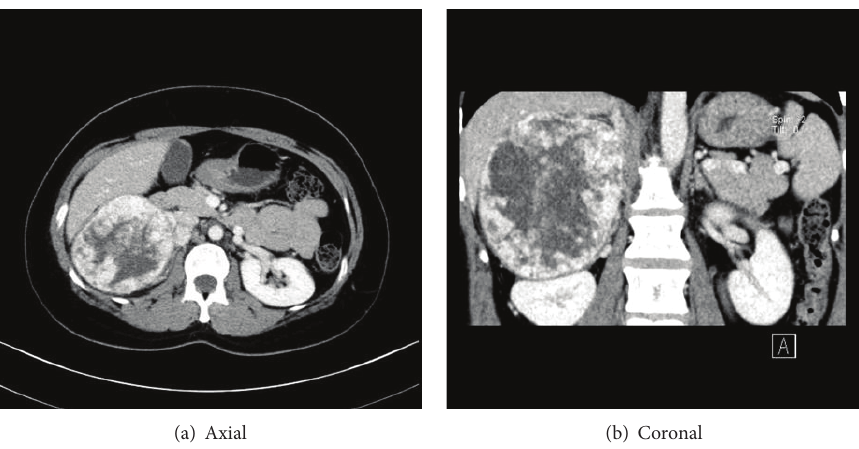
Figure 1: CT scan of the abdomen showing a mass in the right adrenal gland.